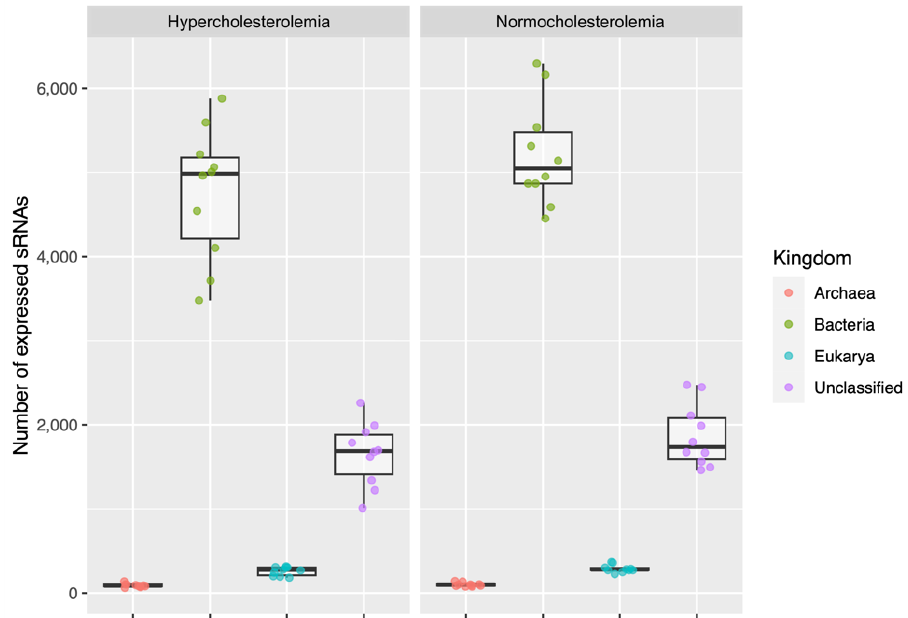
Figure 3. Small RNAs from bacteria, archaea, and eukaryotes, and unclassified ones associated with participants with hypercholesterolemia and normocholesterolemia.